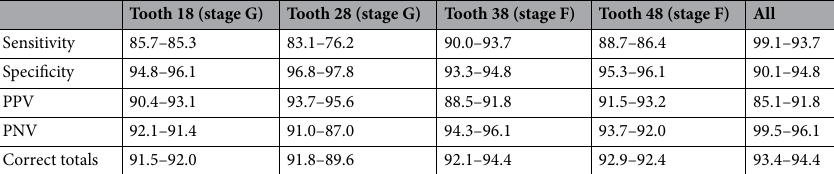
Table 5. Predictive validity (%) of the Demijiran stages for predicting age over 18 years in